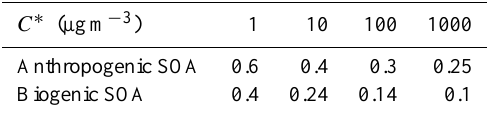
Table 2. O:C Distributions for First-Generation SOA